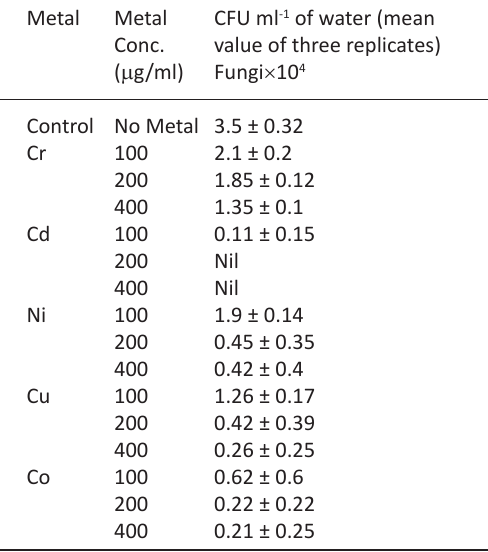
Table 4. Viable count of metal tolerant fungal population in wastewater at varying concentrations of heavy metals Metal